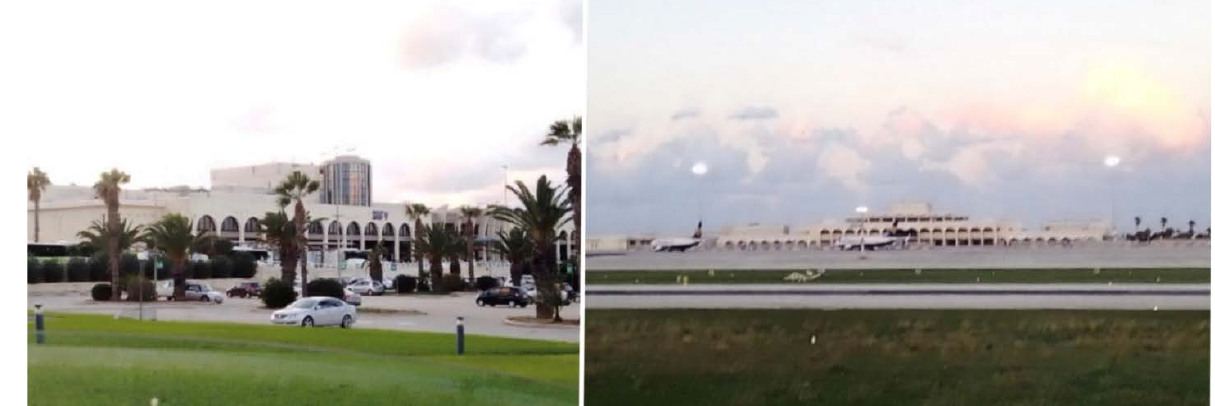
Figure 2. Terminal of MIA (online version is in colour): as at present (left), and as viewed from the side of the runway (right) (© Alessandra Bianco).